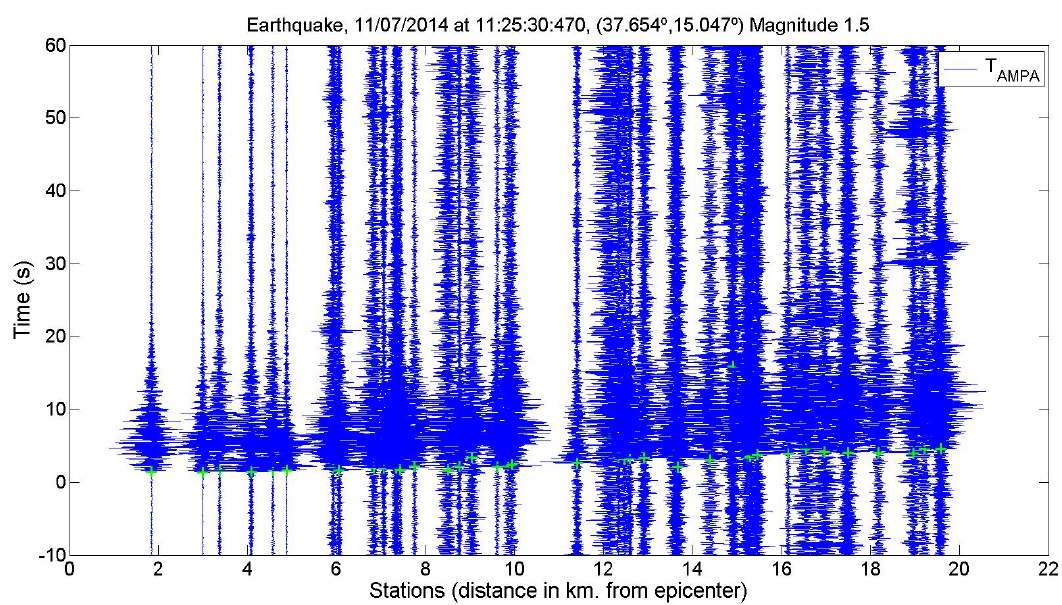
Figure 20. An example of a volcano tectonic earthquake recorded in several portable seismic stations of the TOMO-ETNA experiment lo- cated around Mt. Etna volcano. This earthquake occurred in July 11, 2014.